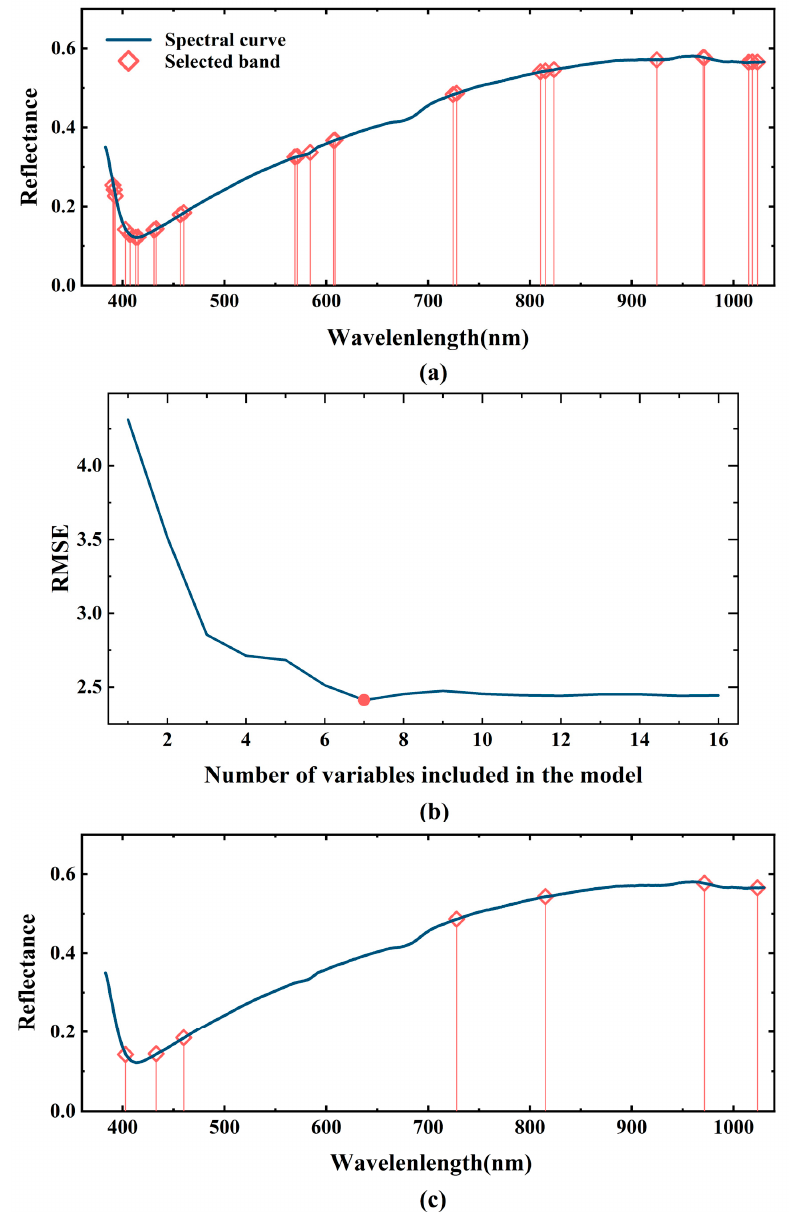
Figure 5. Characteristic wavelengths selected via CARS ( a ) and CARS-SPA( c ), and the RMSE values with the increase of the number of wavelengths in the model ( b with the increase of the number of wavelengths in the model ( b ).